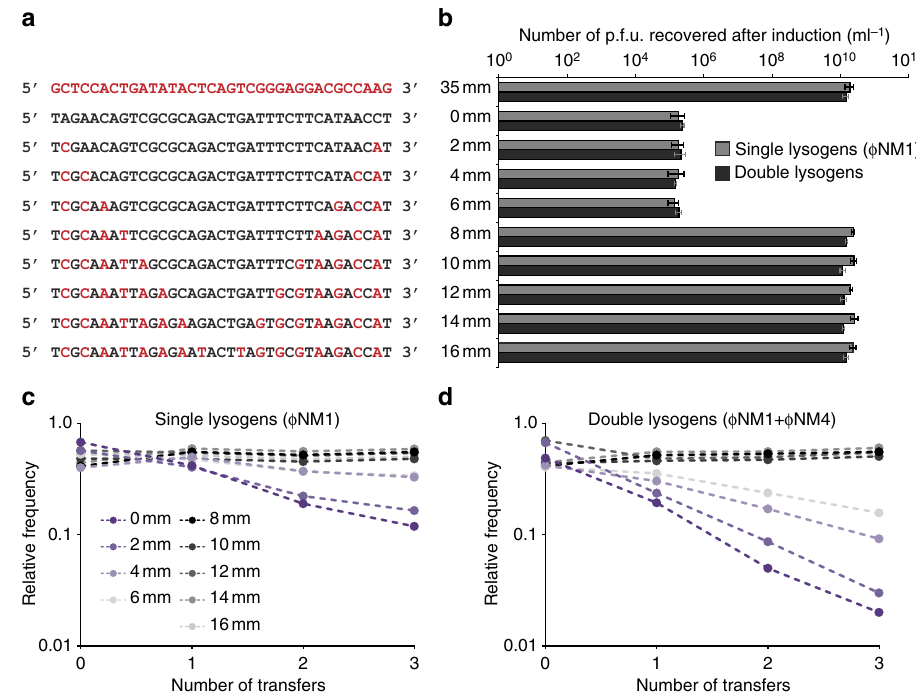
Fig. 4 Effects of spacer-target mismatches in single and double lysogens harboring a CRISPR – Cas system with dual-targeting potential. a Sequence summary of the gp16 spacer and its mismatched variants. Black lettering indicates sequences found in the parental gp16 spacer; red lettering indicates mutated base pairs. A subset of transversion mutations were used to avoid introducing G:U pairing when complementarity between the crRNA and transcribed target RNA is considered. b Quanti fi cation of plaque forming unit concentrations (plaque-forming units per milliliter) in fi ltered supernatants from subcultures of single (TB4:: Φ NM1) or double (TB4:: Φ NM4+ Φ NM1) lysogens harboring the spacers depicted in a , recovered 4 h post treatment with